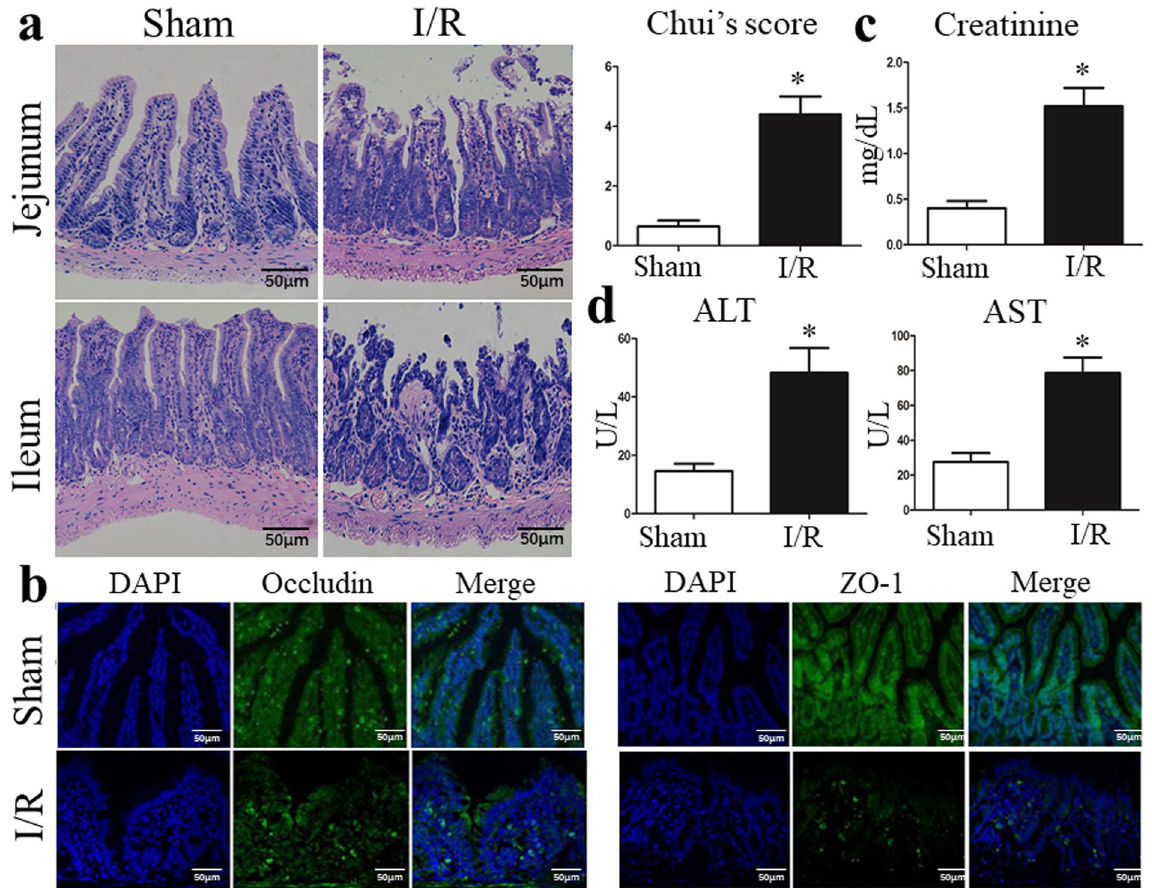
Figure 4. I/R triggers gut injury and intestinal barrier disruption. ( a ) Representative images of intestinal histology (H&E staining; original magnification, × 200) and histopathological scores (Chiu’s score) of the intestine after intestinal I/R. ( b ) Localization of occludin and ZO-1, and DAPI staining within intestinal tissue sections as assessed by immunofluorescence at 6 hours after intestinal I/R. The levels of plasma ( c ) creatinine, ( d ) ALT and AST were also measured by ELISA at 6 hours after I/R. The data were expressed as means ± SD. * p < 0.05 vs the I/R